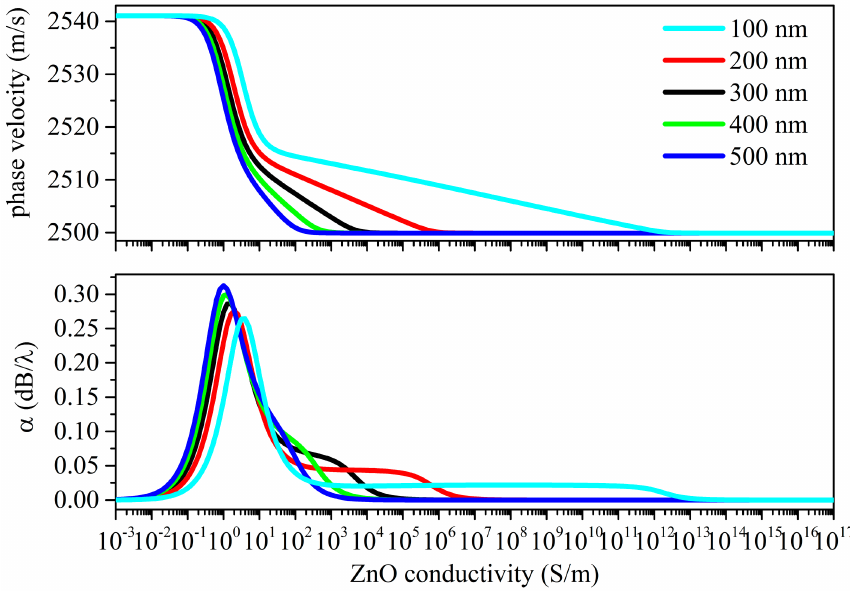
Figure 9. Rayleigh wave phase velocity and propagation loss vs. conductivity curves under bottom illumination; the penetration depth is the running parameter.